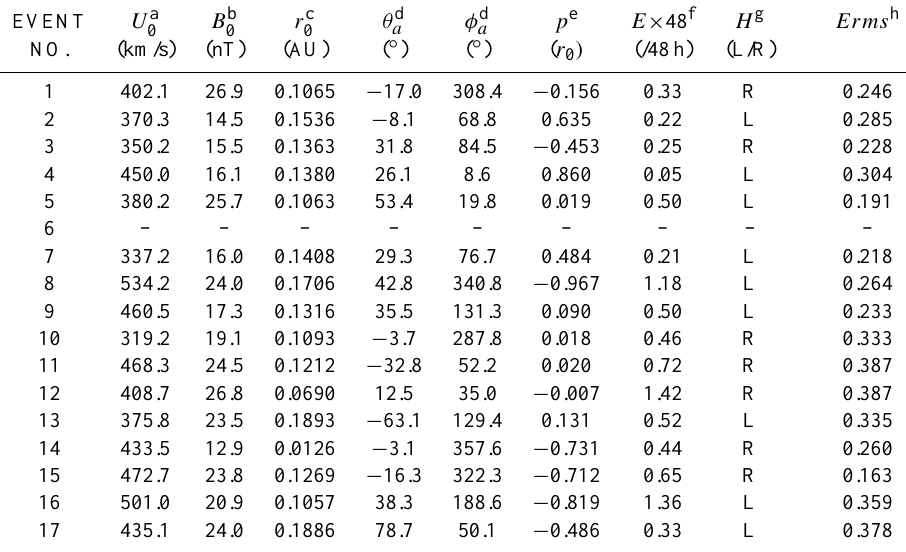
Table 3. Magnetic cloud parameters determined by fitting to the cylinder